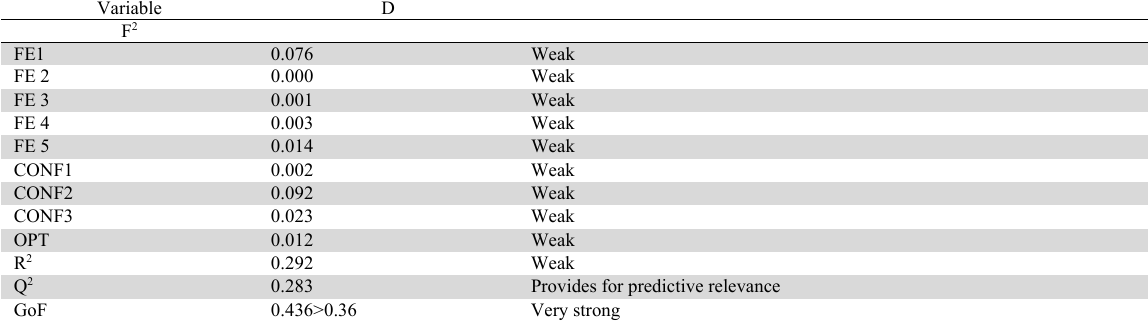
Table A5 Inner Model Analysis (Model I)